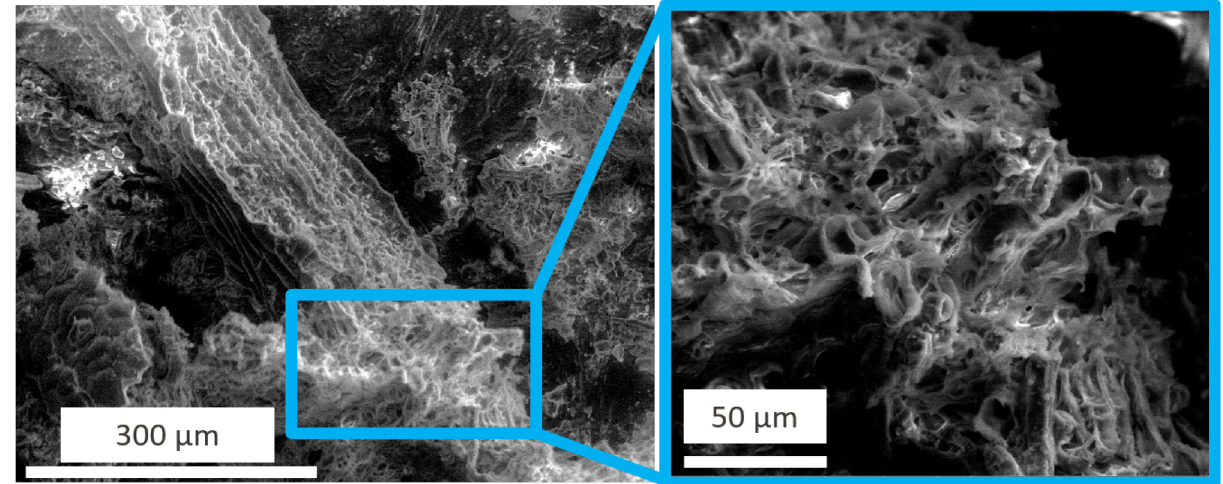
Fig. 26. Evidence obtained through SEM observation (SE detector, 15 kV) of a sponge-like structure (with porosities) of a third body collected during a test (RH = 85%, slip rate: